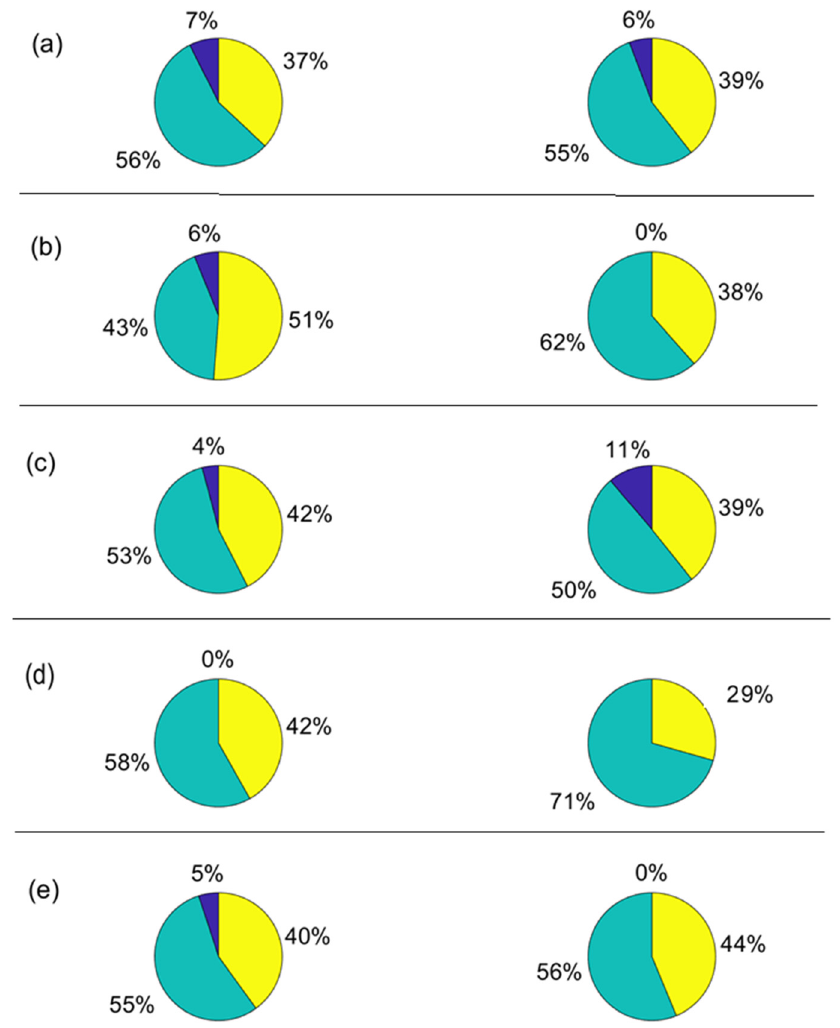
Figure 5. Devices used by male (left column) and female (right column) students in the schools: ( a ) Engineering, ( b ) Technology, ( c ) Business, ( d ) IT and ( e ) Music. Legend: blue is desktop users, green is laptop users and yellow is smart phone users. Note: percentage shown in each figure is rounded to nearest whole number and hence the total may or maynot be equal to 100%.